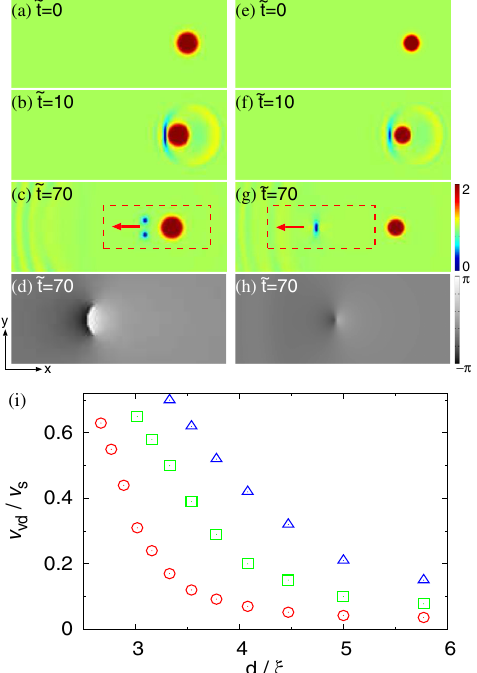
and phase 0 ¼ 0 : 47 and =v 0 s ¼ 0 : 47 (circles), 0.44 =v 0 s